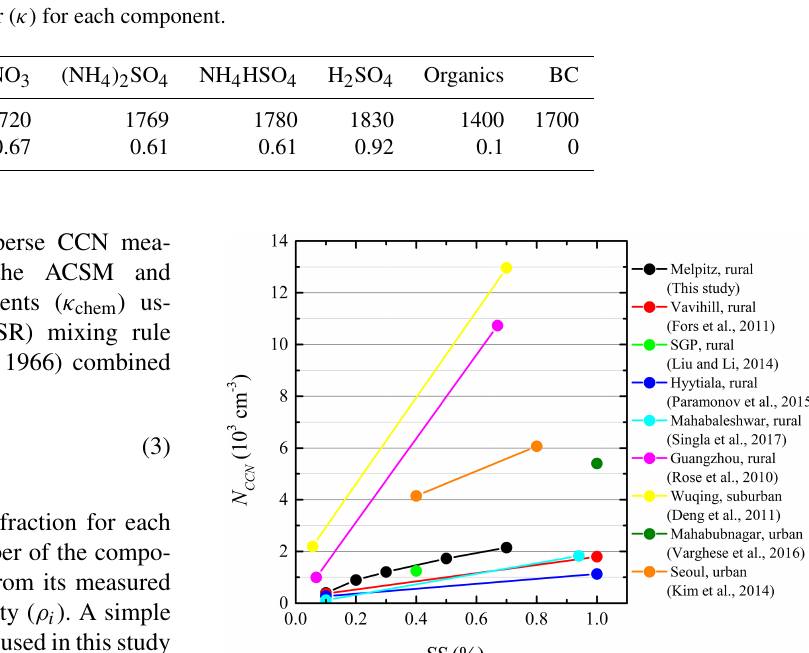
Table 1. Densities ( ρ ) and hygroscopicity factor ( κ ) for each component.